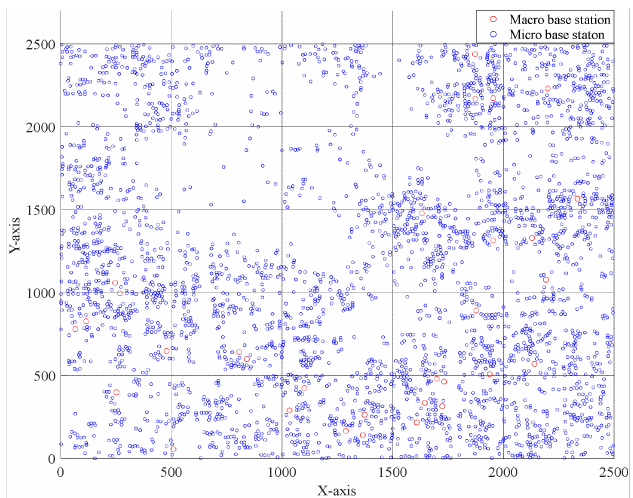
Figure 7. Diagram showing where to locate the new base